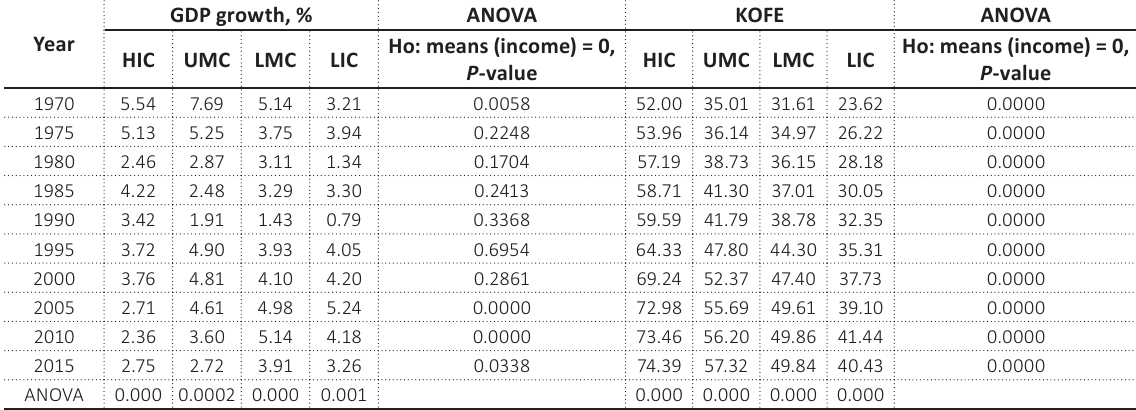
Table 2. Mean 5-year values of GDP growth and KOFE across income groups